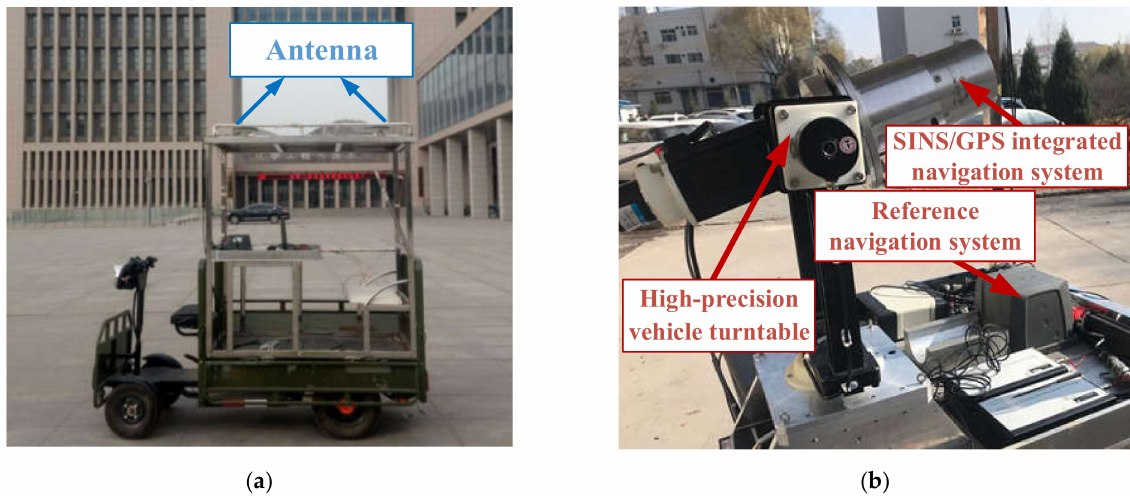
Figure 11. Vehicle experiment platform: ( a ) Vehicle platform; ( b ) experimental equipment.